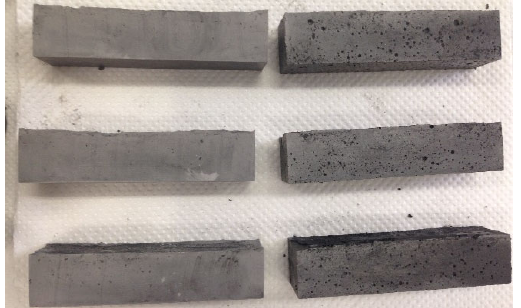
Figure 7. MWCNT/white cement mortar specimens dispersed with the superplasticizer on the left and the SDBS surfactant on the right.